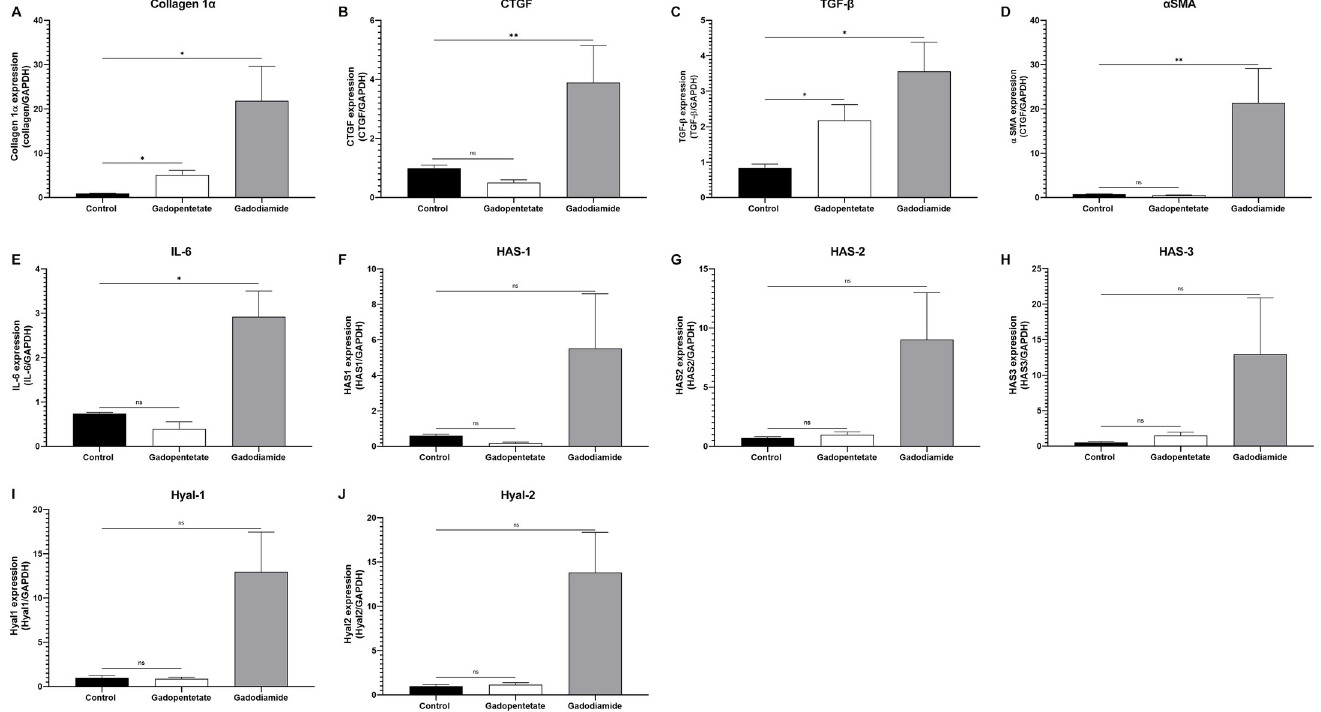
Fig 1. The mRNA expression of the fibrotic marker in the mice skin with lesion. mRNA levels of Collagen 1 α , CTGF, α SMA, TGF- β , HAS-1, HAS-2, HAS-2, HAS-3, Hyal-1, and Hyal-2 were evaluated in the skin lesion after Gd injection. Mice with severe skin lesions in the gadodiamide group showed high fibrotic markers similar to those found in NSF skin lesions (A-E, G, I-J). In mice with mild lesions, HAS-1 and HAS-3 were not increased while other mRNA levels were (F, H). In the gadopentetate group, collagen 1 α and TGF- β mRNA expression were increased, while CTGF expression was decreased (A-C). Other mRNA expression in the gadopentetate group were similar to the control group. mRNA level in control mice were assigned as values of 1. ns = not significant, � p < 0.05, �� p < 0.01.